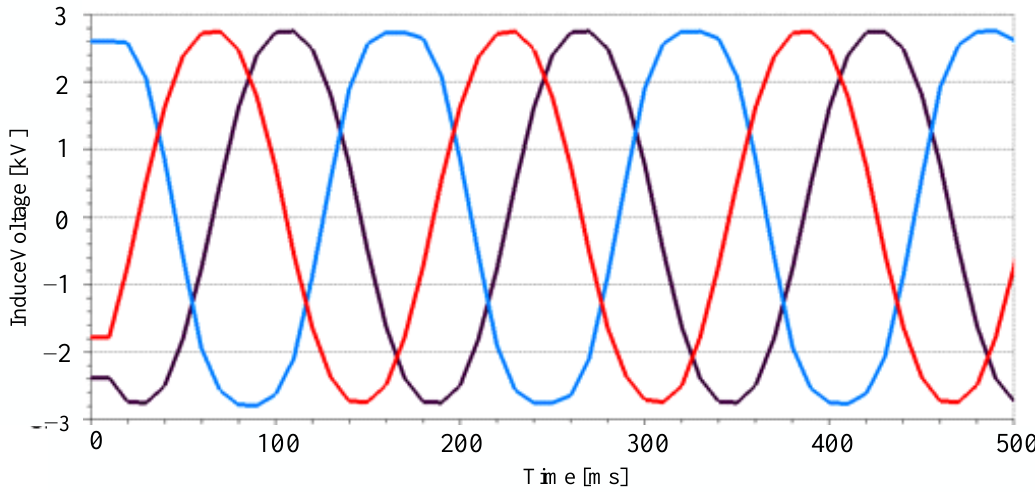
Figure 10. Back-EMF waveform of the CPMLG.